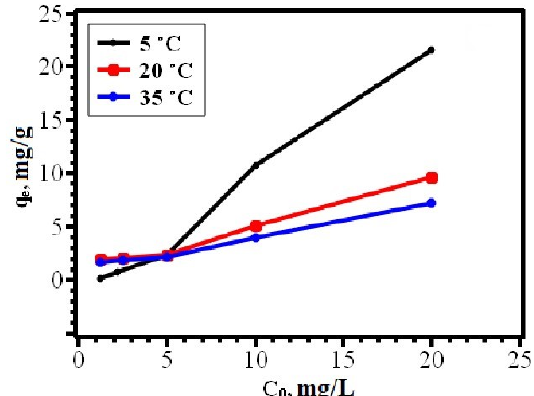
Figure 6. Dependence of the extraction on the initial concentration of the sorbate for IC dye.